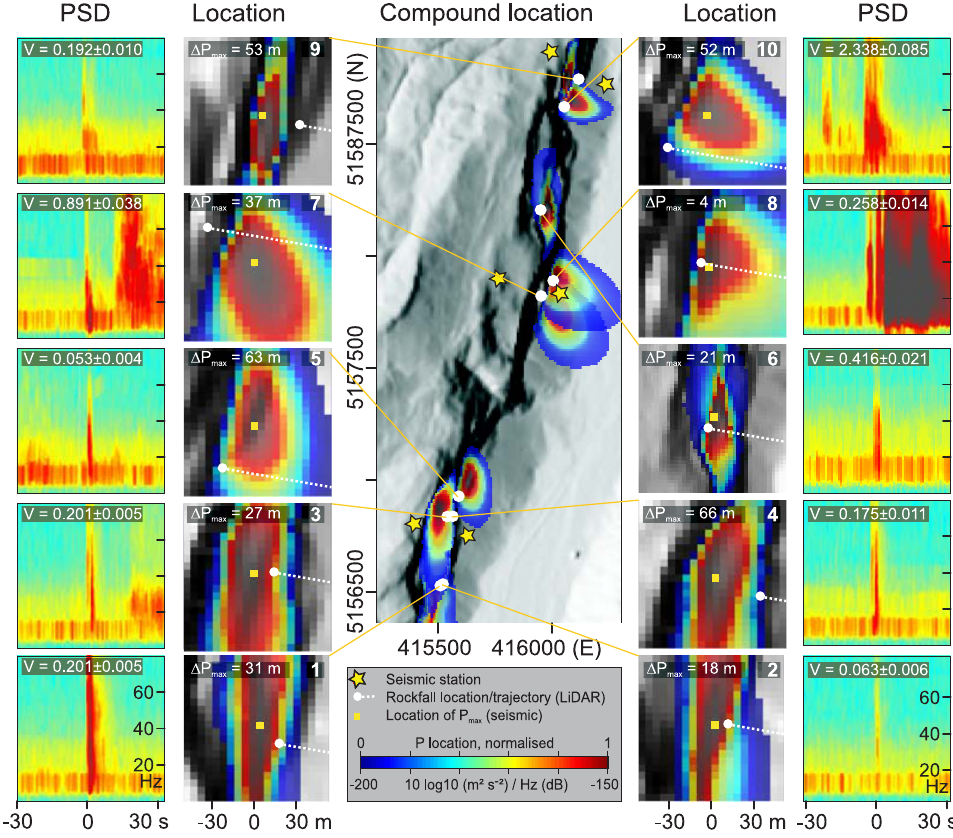
Figure 9. Seismic location of the 10 TLS-based rockfall events. Compound location map shows an overlay of all 10 detected events with coloured polygons corresponding to locations with cross-correlation values above the 0.973 quantile. Location close-up boxes are centred at P max , i.e. the location with the highest cross-correlation value. PSD boxes show the spectral evolution of each event as recorded by station “Funny Rain”. Event start is indicated by time zero. For event duration see Table 2. (cid:49)P max is the deviation of seismic location estimate from rockfall trajectory along steepest path. Locations of all rockfalls shown based on optimised location frequency windows for illustrative reasons (see Table 1 for default